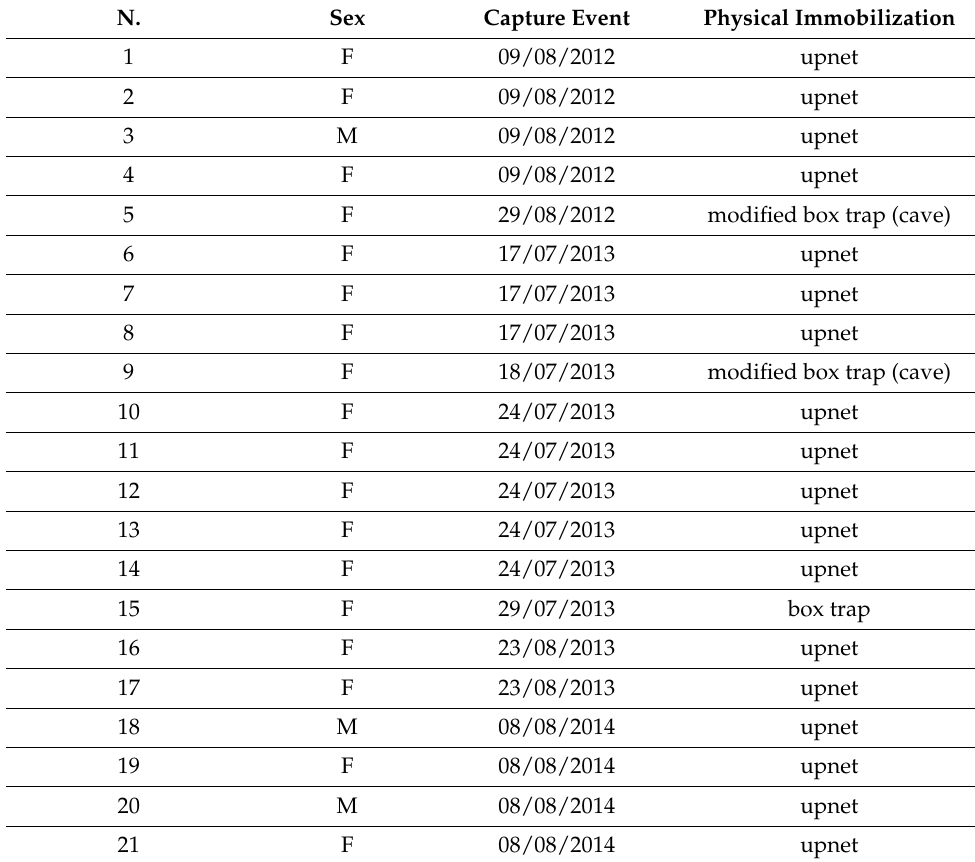
Table 1. List of captured Apennine chamois.